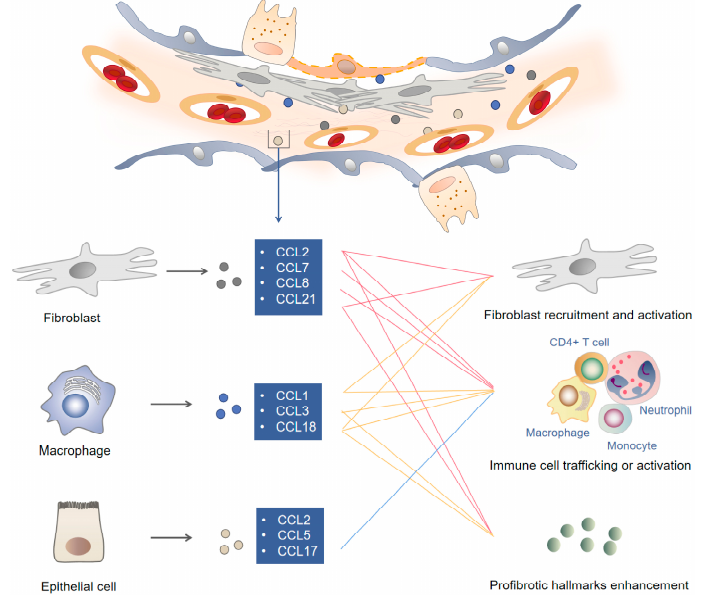
Figure 1. Chemokines and corresponding mechanisms involved in the pathogenesis of idiopathic pulmonary fibrosis. Repetitive stimulation of detrimental initiators leads to long-term pulmonary epithelium impairment. Failure to eliminate initiating factors induces chronic inflammation in the lung. Released chemokines such as CCL1, CCL2 and CCL18 recruit immune cells, impair epithelial cells and activate myofibroblasts to form a profibrotic microenvironment in fibroproliferative lesions. Modulating CCL content favors the alleviation of extracellular matrix deposition and profibrotic hallmark enhancement.